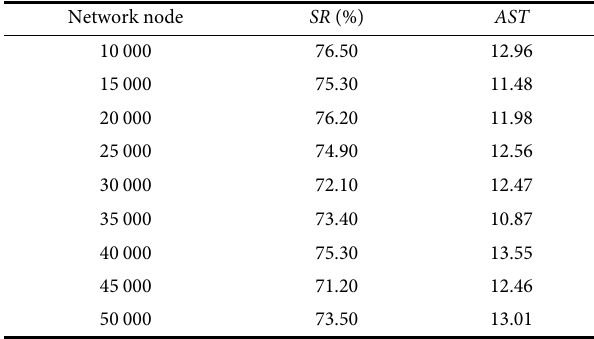
Table 3 Expansibility test results. Network node